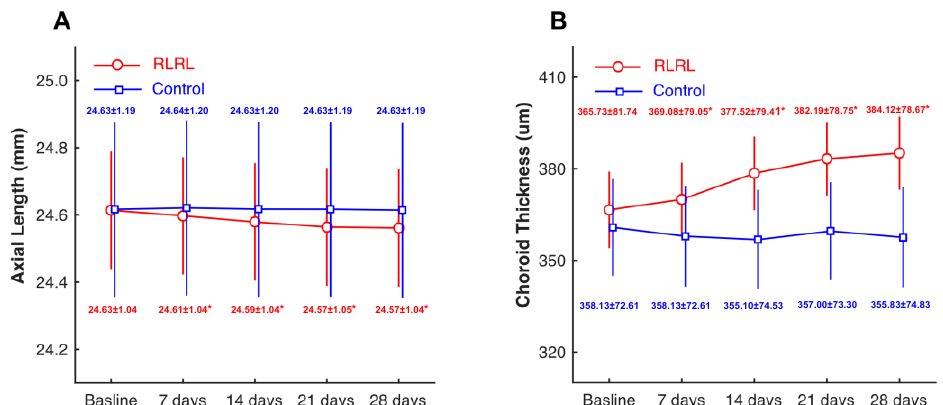
Figure 2. Time course of axial length and choroidal thickness in two groups. Compared with the control group (blue line), the RLRL group (red line) had decreased axial length ( A ) and increased choroid thickness ( B ) after treatment. * p < 0.05 when compared to the baseline.